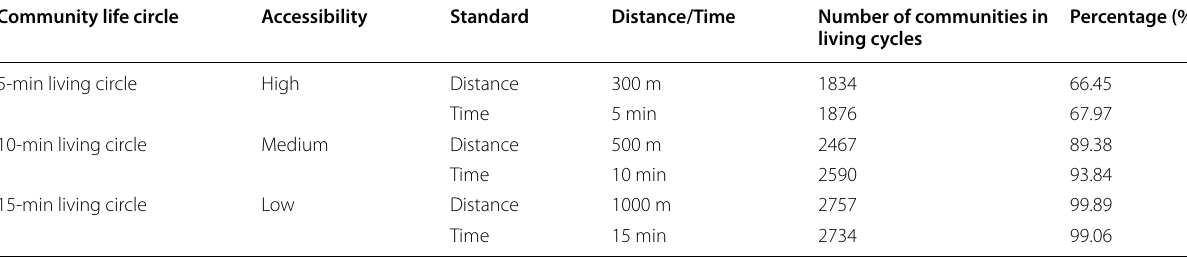
Table 5 Quantitative results of accessibility to CGBPs based on the theory of the community life circle Community life